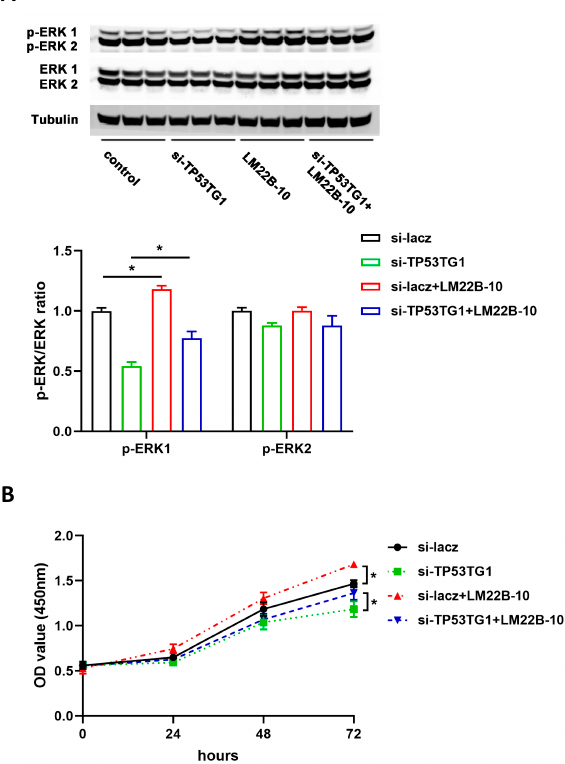
Figure 5. TP53TG1 works through the ERK pathway. ( A , B ) Protein expression level (top) and quantification (bottom) of p-ERK1/p-ERK2 and ERK1/ERK2 ( A ), and cell proliferation rate, error bars represent SD, n = 6 ( B ) in HepG2 cells treated with si-lacz, si-TP53TG1, si-lacz + LM22B-10, or si-TP53TG1 + LM22B-10. The protein expression levels of p-ERK1 and p-ERK2 were normalized to ERK1 and EKR2, respectively. * p < 0.05.